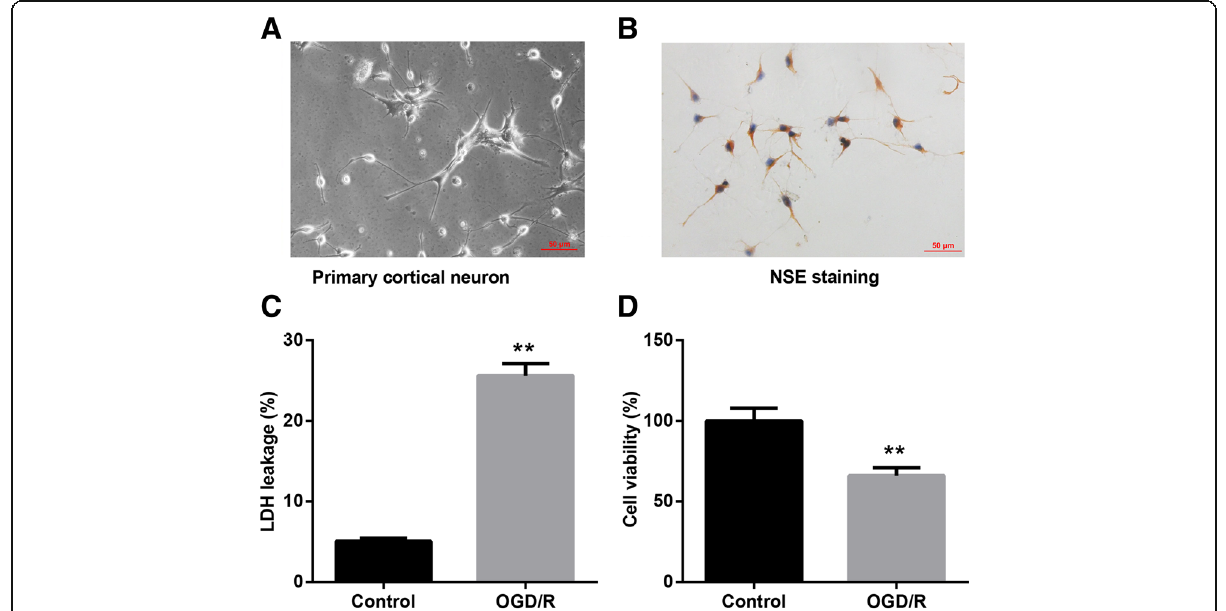
Fig. 1 Establishment of neuronal ischemia-reperfusion injury model. Primary cerebral cortical neurons were prepared from Sprague-Dawley rats, and an in vitro cellular model of cerebral ischemia and reperfusion injury was induced by oxygen-glucose deprivation/reoxygenation (OGD/R). a Morphological changes of the rat primary cortical neurons cultured for 10 days were observed under a microscope (scale bar: 50 μ m). b Neuron- specific enolase (NSE) immunohistochemistry staining in cortical neurons (scale bar: 50 μ m). c Cell injury of cortical neurons exposed to OGD/R was evaluated by lactate dehydrogenase (LDH) release rate, and d cell viability was assessed by the CCK-8 assay. Values are represented as the mean ± SD from three independent experiments. ** p < 0.01 vs. Control